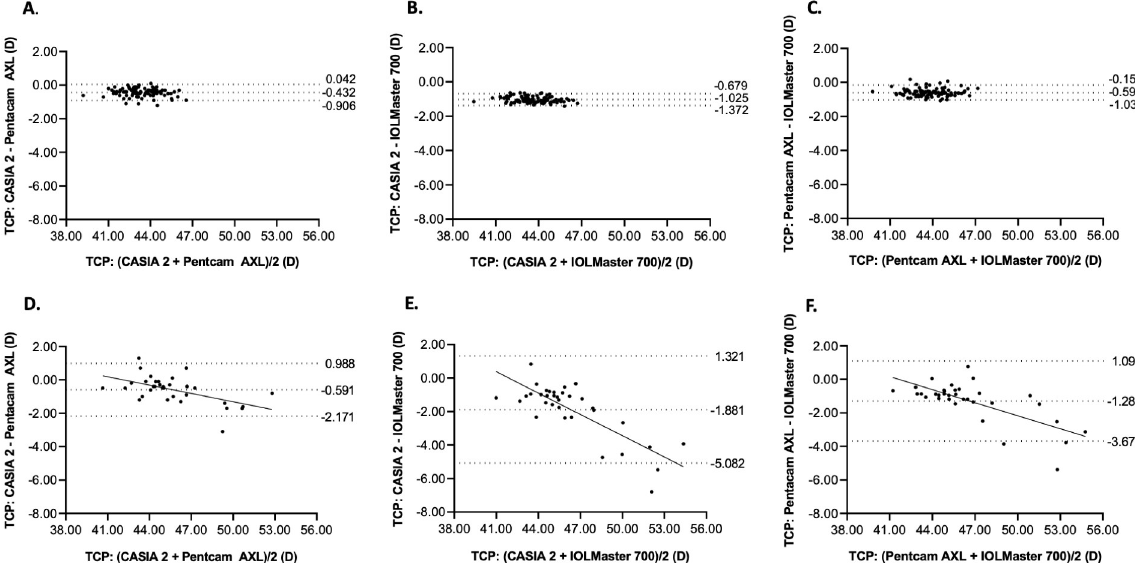
Fig 1. Bland-Altman plots of total corneal power between devices in normal and keratoconic eyes. Bland-Altman plots showing the agreement of total corneal power between CASIA 2 and Pentacam AXL (A, D), CASIA 2 and IOLMaster 700 (B, E) and Pentacam AXL and IOLMaster 700 (C, F) in healthy (A-C) and keratoconic (D-F) participants. The middle-dashed line shows the mean difference, and the top and bottom dashed lines show the upper and lower 95% limits of agreement, respectively.